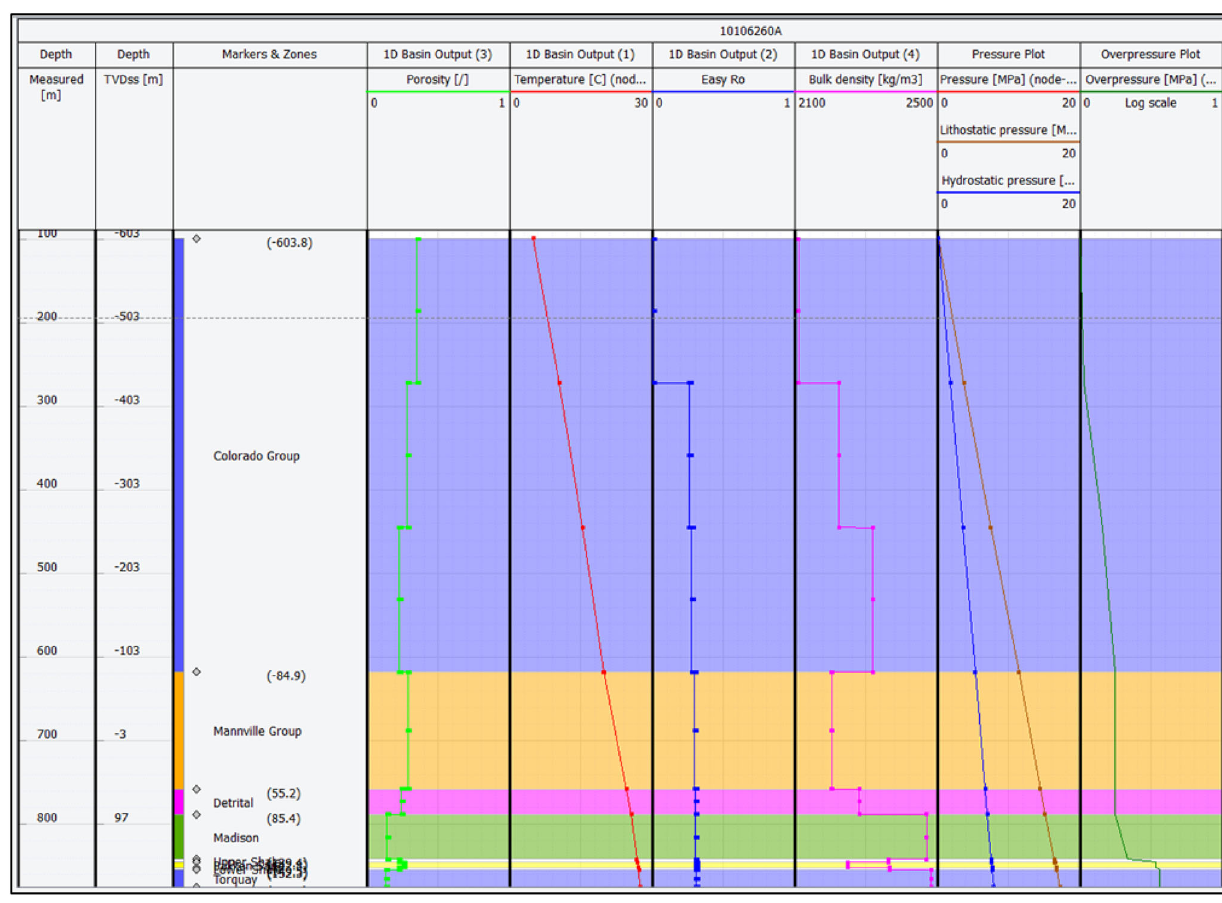
Fig. 7 Output of 1D basin modeling process in terms of reservoir elastic properties and pressure regim